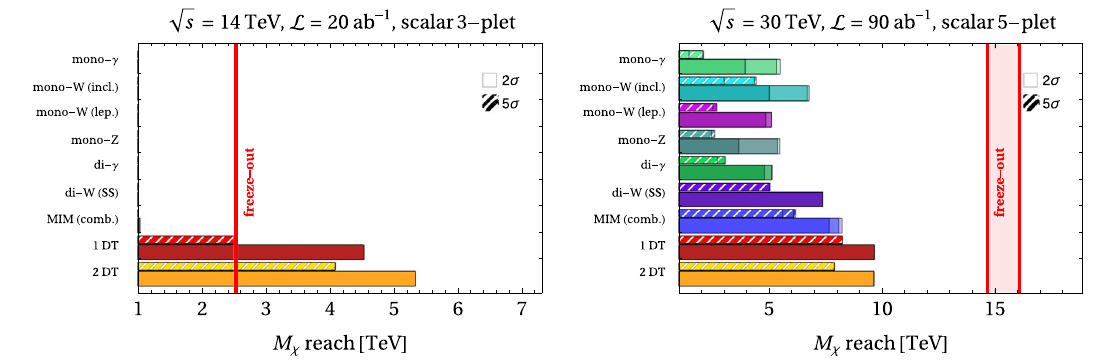
Fig. 12 Different bars show the reach at 2 σ (full wide) and at 5 σ (hatchedthin)ontheWIMP massata muoncolliderwithbaselinelumi- nosity given by Eq. (24) for the different search channels discussed in Sect.5.1:mono-gamma,inclusivemono-W,chargedmono-W,mono-Z, di-gamma,same-signdi-W,thecombinationofalltheseMIMchannels (blue). We also show the reach of disappearing tracks as discussed in